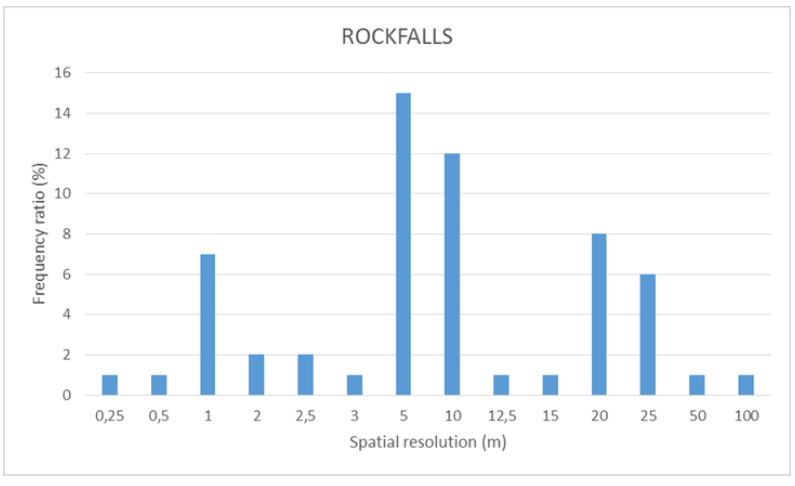
Figure 5. The frequency of use of different spatial resolutions in rockfall investigations.